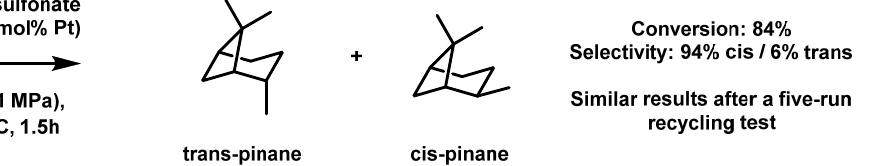
Figure 28. Application of platinum nanoparticles deposited sodium lignosulfonate to the hydro- genation of alpha-pinene